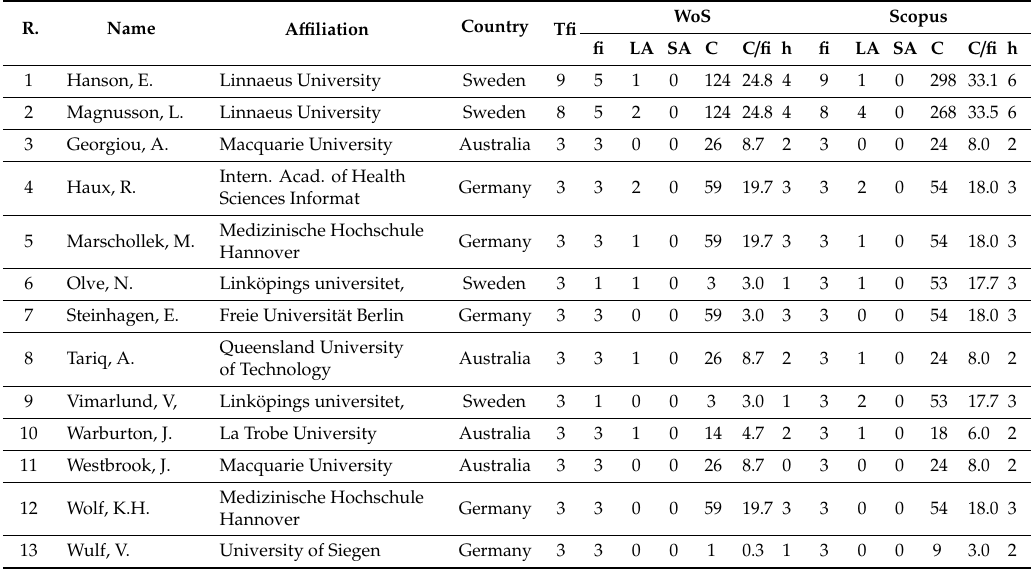
Table 3. Authors with the highest number of